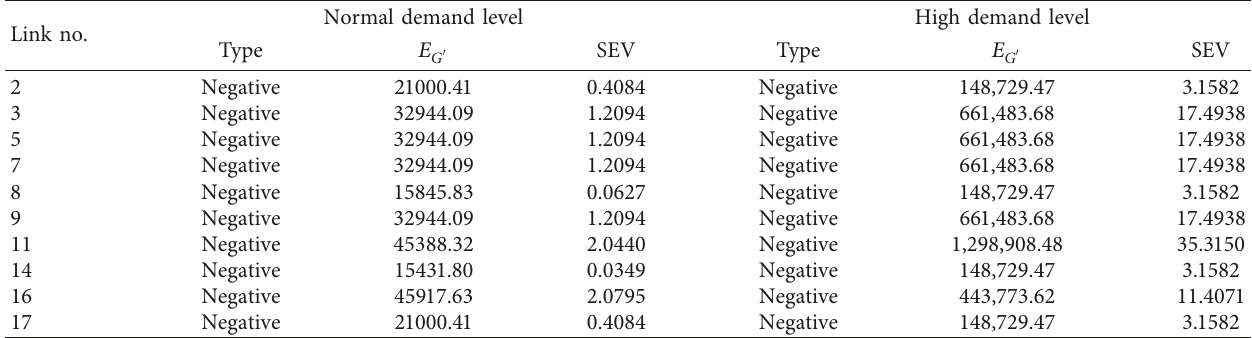
Table 9: SEV for the transportation